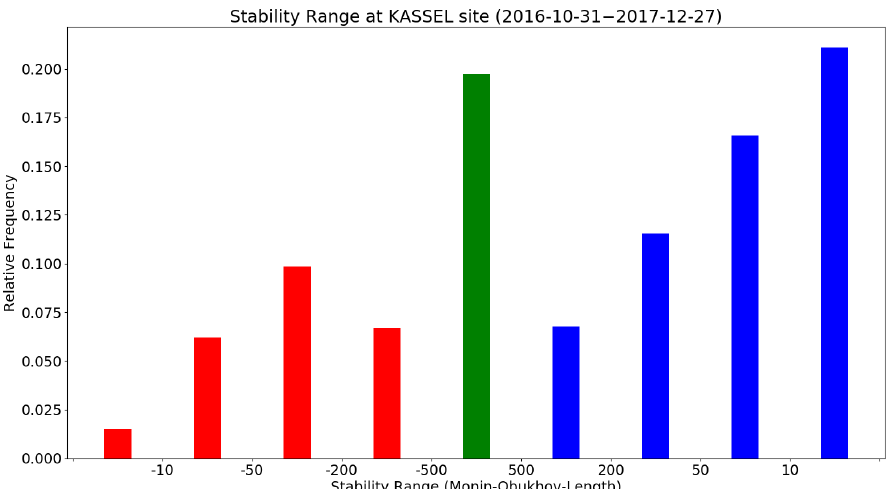
Figure 4. Stability range at Rödeser Berg (meso-scale model data) for the time window of the measurement campaign. The colors depict the stability, which is assumed by the downscaling method, when stability is applied. convective in red, stable in blue and neutral in